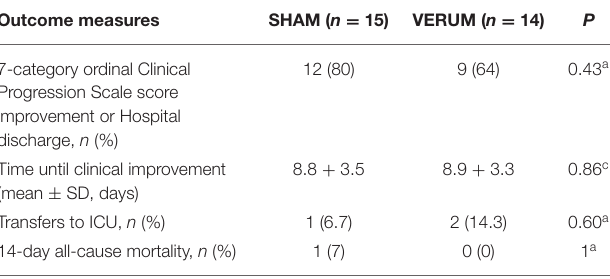
TABLE 2 | Clinical evolution of patients during the medical follow-up. Outcome